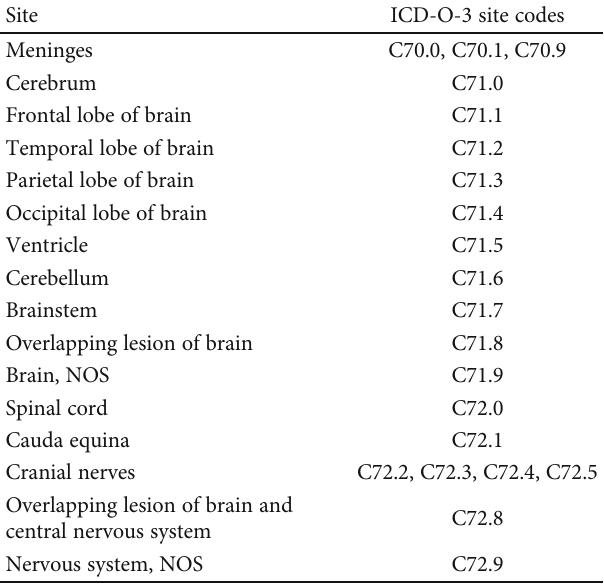
Table 1: ICD-O-3 topography (site)